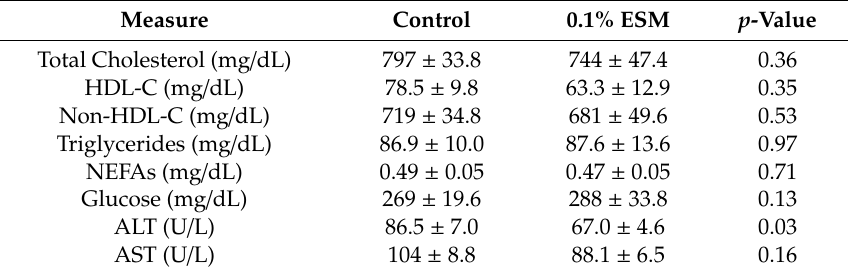
Table 2. Serum Biochemical Analysis.